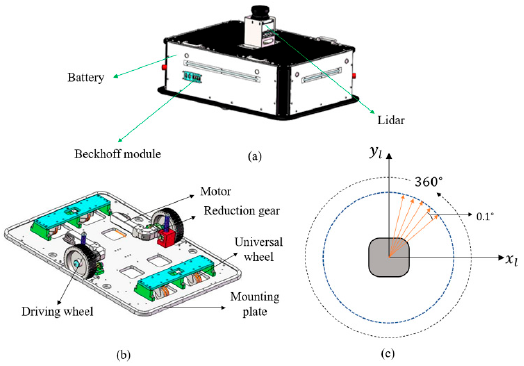
Figure 1. Robot modeling and its component parts. ( a ) Overall framework of mobile robot. ( b ) Hardware parts of mobile robot. ( c ) Partial parameters of 2D Lidar.